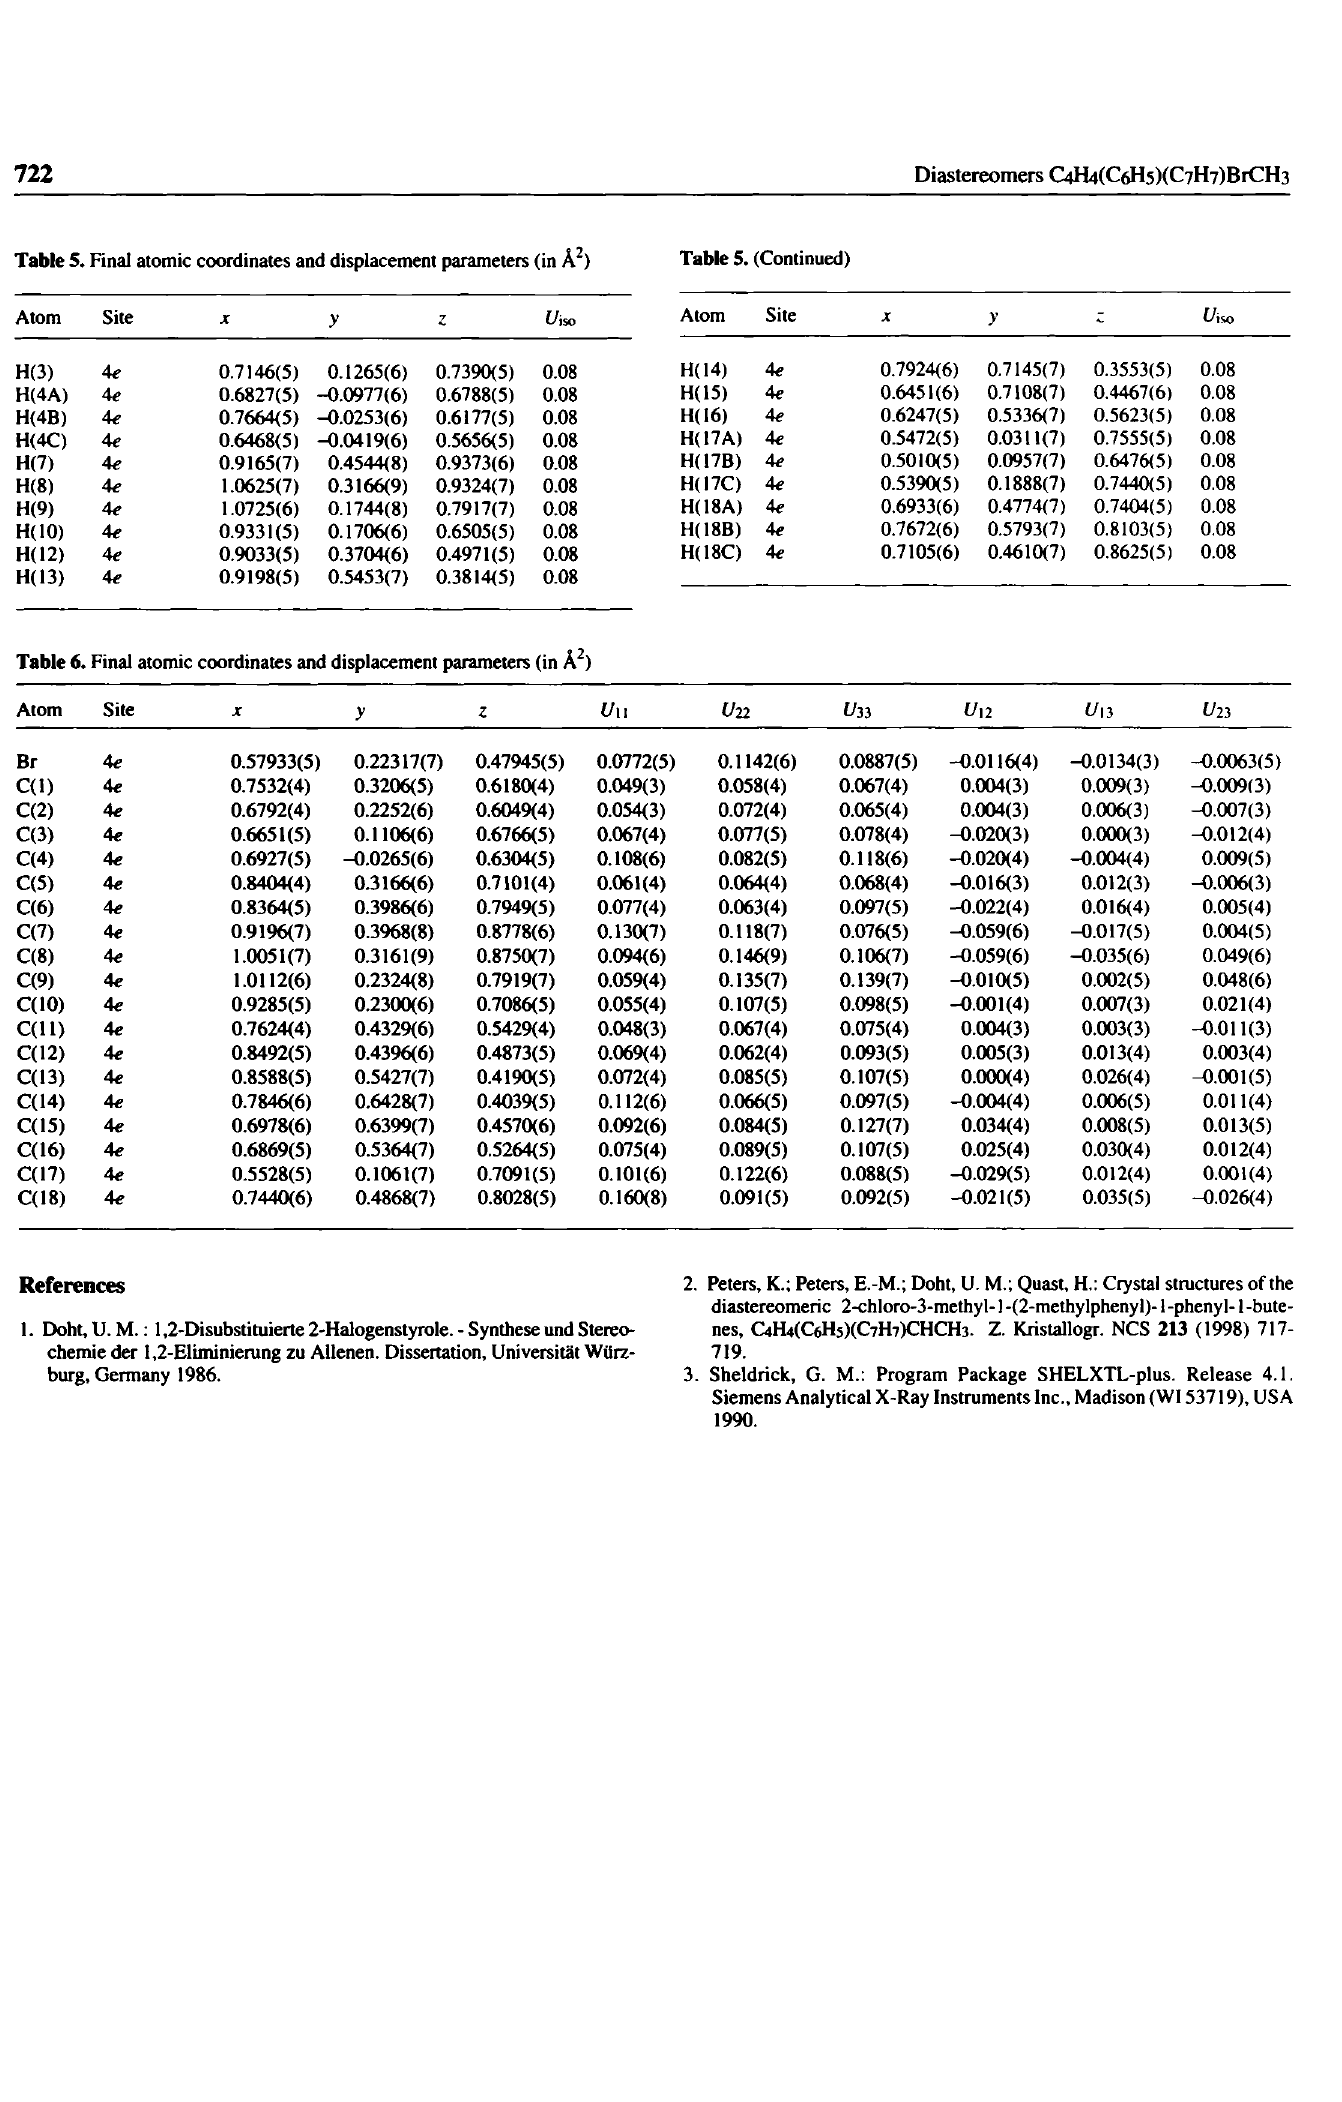
Table 6. Final atomic coordinates and displacement parameters (in